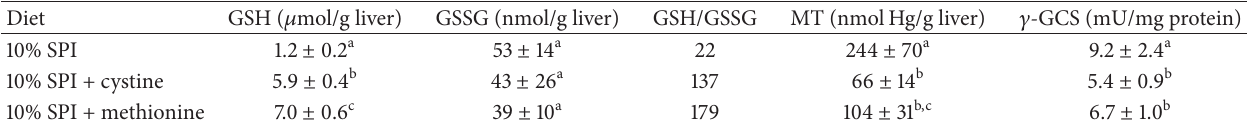
Table 2: Effect of diet on concentration of glutathione (reduced and oxidized forms), metallothionein (MT), and 𝛾 -glutamylcysteine synthetase ( 𝛾 -GCS) activity in rat